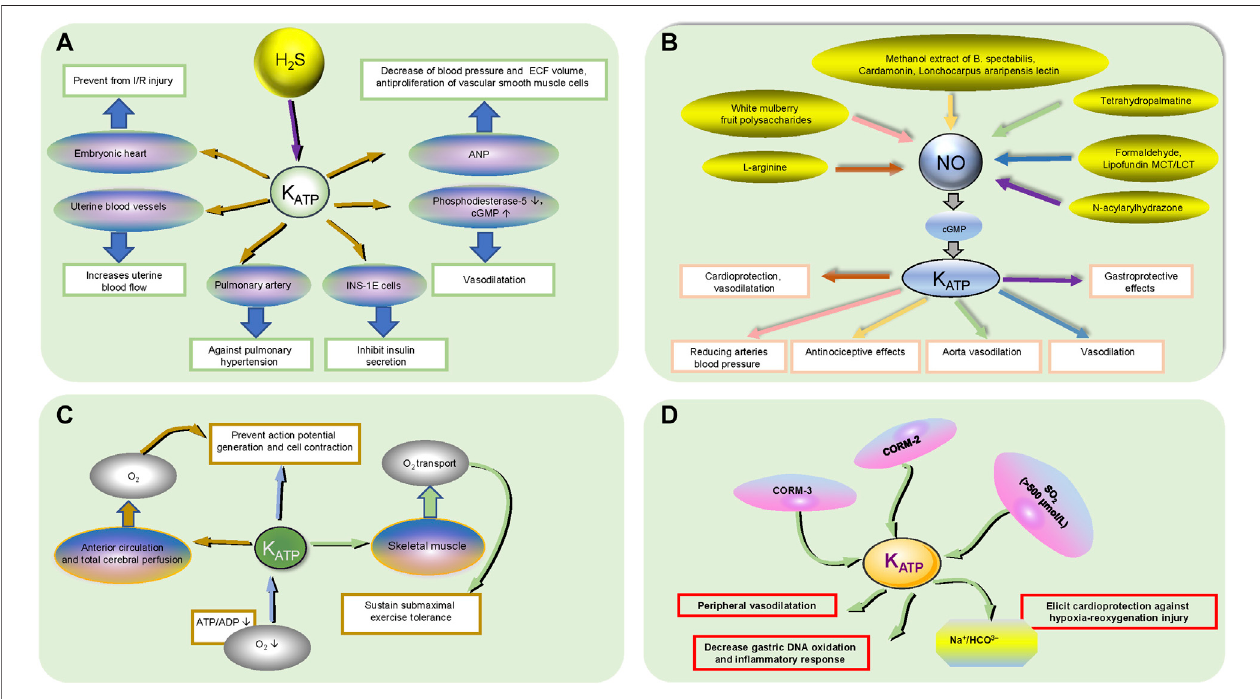
FIGURE 3 | The functional regulation of active small molecules on K ATP channels. (A) H 2 S participates in K ATP channel regulation. H 2 S acts on the corresponding organ/tissues/cytochemical small molecules in the oval through K ATP channels to produce physiological effects in a rectangular box. The black up and down arrows inside the ellipse represent increasing and decreasing, respectively. (B) . NO participates in K ATP channel regulation. The relative drugs in the ellipses produce physiological effects in the rectangular boxes through the K ATP channels and NO/CGMP signaling pathways, which the reaction goes in the direction of the arrows in the same color. (C) . O 2 participates in K ATP channel regulation. Hypoxia results in a decrease in ATP/ADP acting on K ATP channels to prevent action potential generation and cell contraction; The K ATP channel acts on skeletal muscle and affects O 2 transport to sustain submaximal exercise tolerance; The K ATP channel affects anterior cerebral circulation and total cerebral perfusion through O 2 transport to prevent action potential generation and cell contraction. The black up and down arrows inside the ellipse represent increasing and decreasing, respectively. (D) . Other small active molecules. CORM-3 can mimic the HO-1/CO pathway, activate mitoK ATP channelsandelicitcardioprotectionagainsthypoxia-reoxygenationinjurybyinhibitingtheNa + /HCO 3 − transporter;CORM-2alleviatesgastriclesionsatthesystemiclevel via K ATP channels, reducing gastric DNA oxidation and in fl ammatory responses; SO 2 plays a vasodilatory role through K ATP channel activation in the peripheral cardiovascular system at high concentrations ( > 500 μ